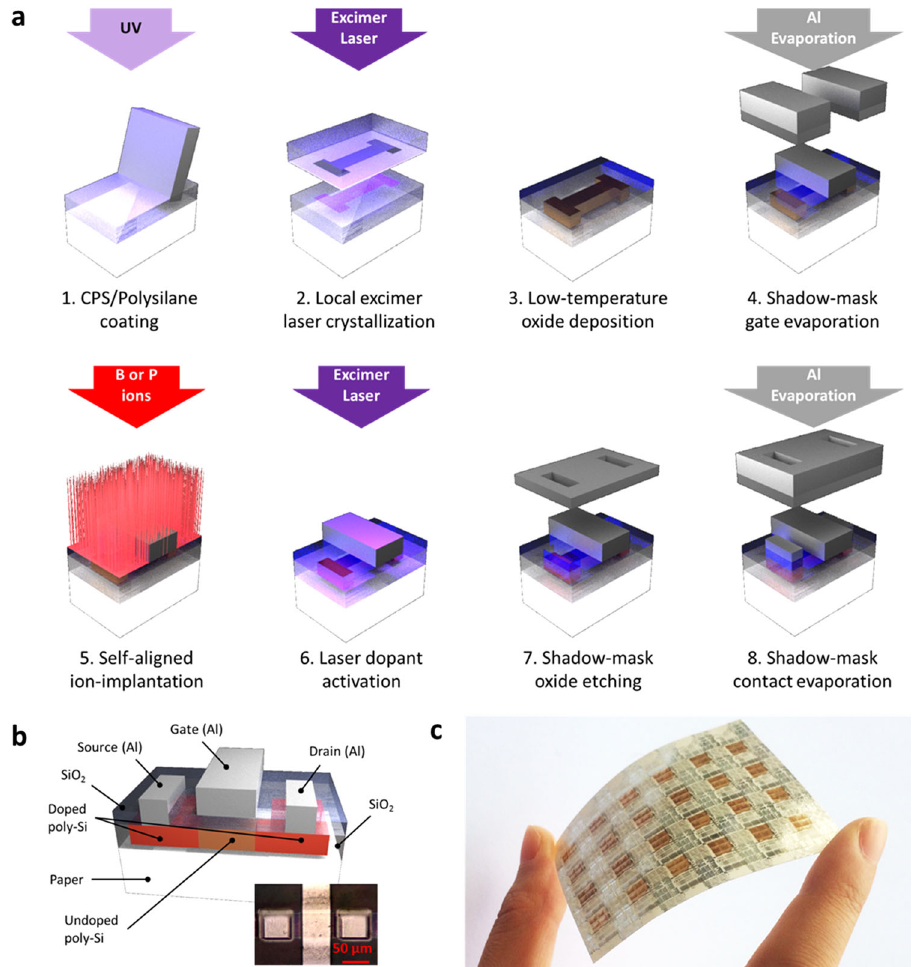
Fig. 2 Full liquid-Si-based TFT on paper fabrication process and results. a Diagram of the fabrication process of solution-based poly-Si TFTs on a paper substrate, starting with coating of CPS with UV light, excimer laser crystallization of the poly-Si channel, low-temperature oxide deposition, shadow mask gate evaporation, self-aligned ion-implantation, excimer laser dopant activation, shadow mask oxide etching, and fi nally shadow mask contact evaporation. b Diagram of the TFT cross-section with a microscope image of the fabricated TFT, red line indicating a size of 50 μ m. c Optical image of the fi nal sample of electronics on a paper